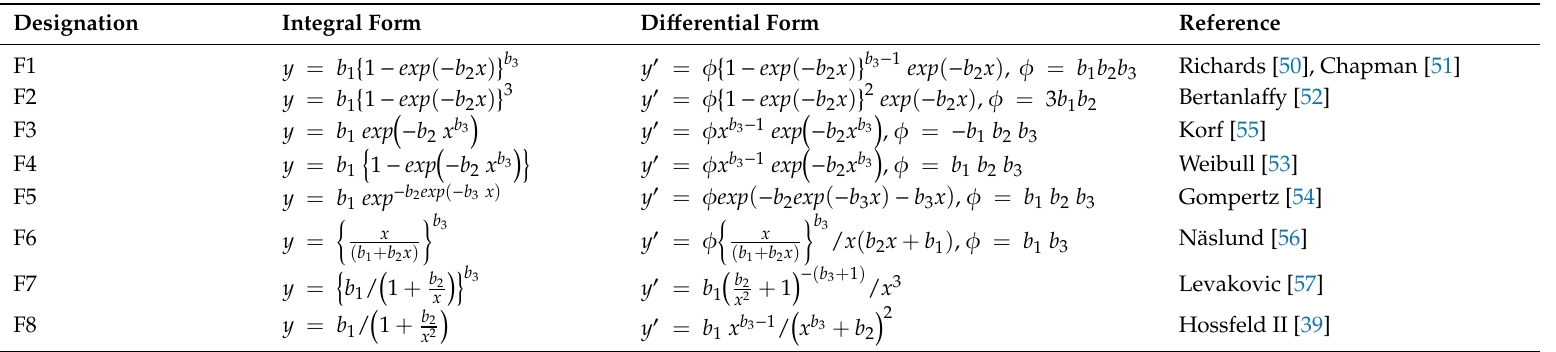
Table 3. The integral forms of the functions used to derive di ff erential forms that were fitted to data; φ , b 1 , b 2 . b 3 are parameters to be estimated, y = integral form of a response variable; y’ = di ff erential form of a response variable (per year diameter increment, ∆ DBH ij ); x = main predictor variable (diameter at breast height, DBH ij ); index i stands for i th sample plot, and j stands for j th tree; F1, F2, ... ,F8 are symbols of the functions